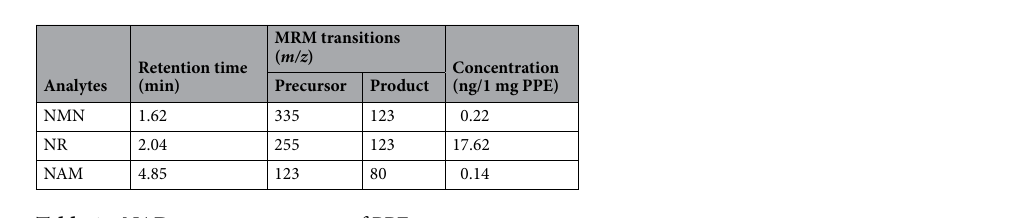
Table 1. NAD precursor contents of